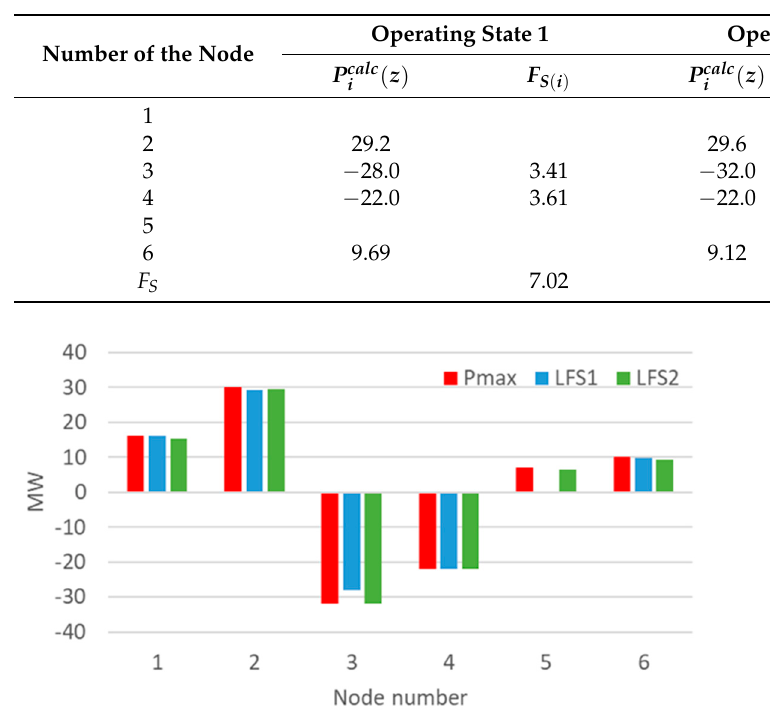
Table 2. Calculation results (P (MW)).